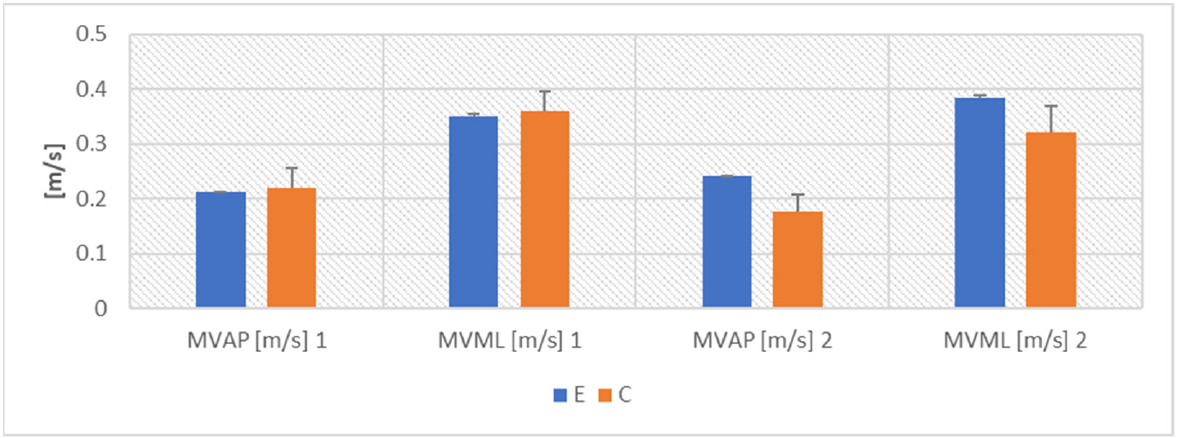
Figure 3. Mean values ± SD of COM velocity.